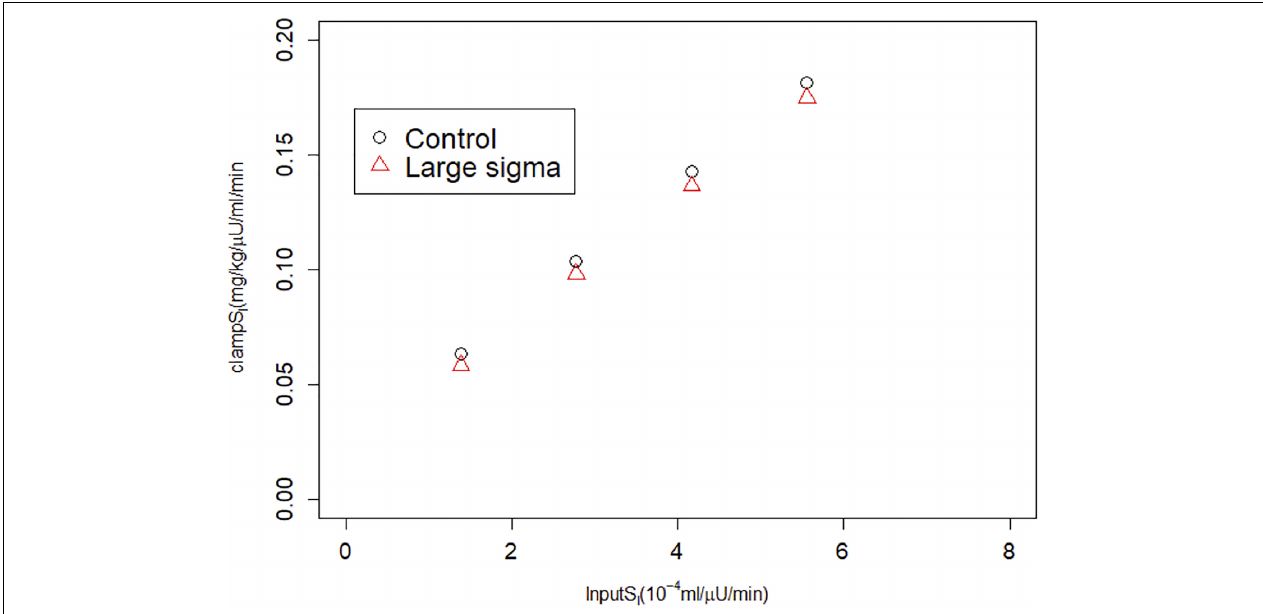
FIGURE 7 | HIEC correctly recovers the assumed S I independent of vesicle docking rate σ and hence AIR. Control cases correspond to Control 1–4 in Figure 3 ; Large sigma cases correspond to the same cases but with σ increased